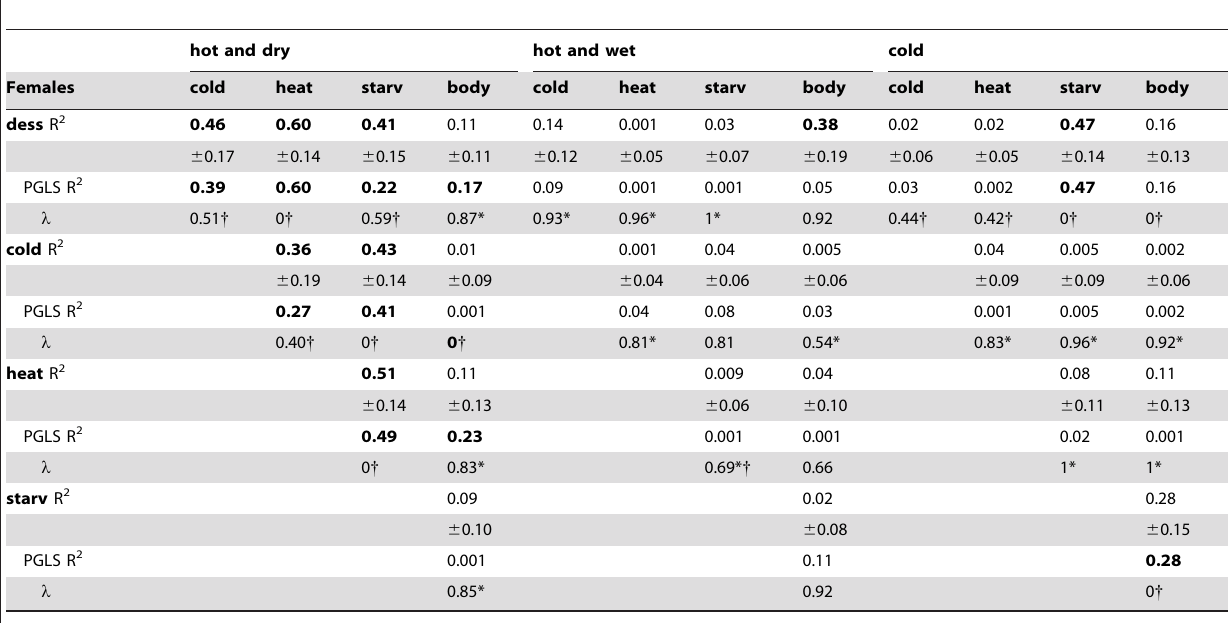
Correlations are presented uncorrected and corrected for phylogeny (PGLS). Significance is highlighted in bold with correlations corrected for multiple comparisons using a sequential Bonferroni approach. Estimates of phylogenetic signal are given as l with * indicating l significant different from 0, while { indicates l significant different from 1.